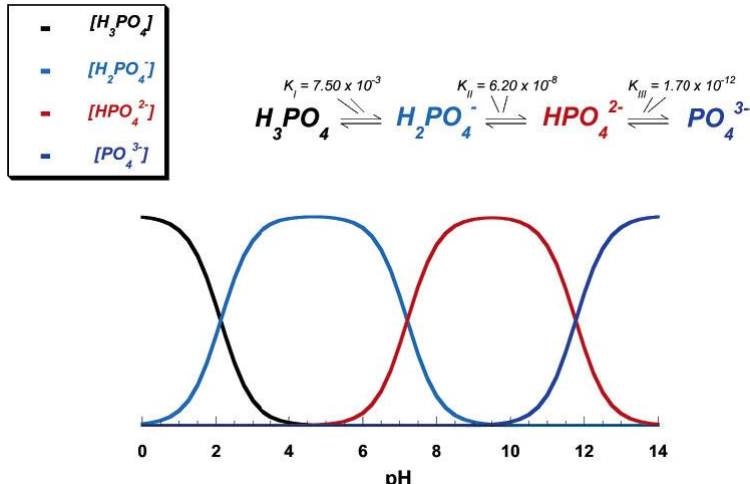
Figure 2. pH variation of ionic concentrations in triprotic equilibrium for phosphoric acid solutions. Reprinted from Ref. [77] with